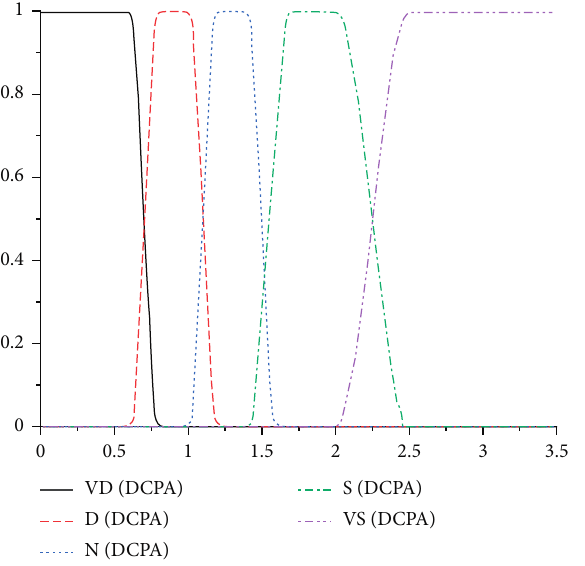
Figure 6: D membership function image.